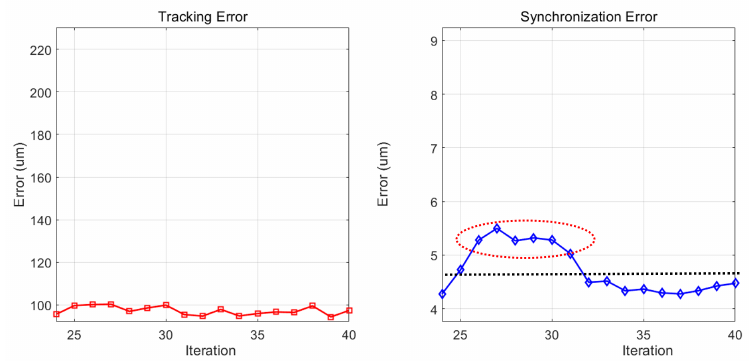
Figure 10. Robustness test for varying system in gantry type testbed.